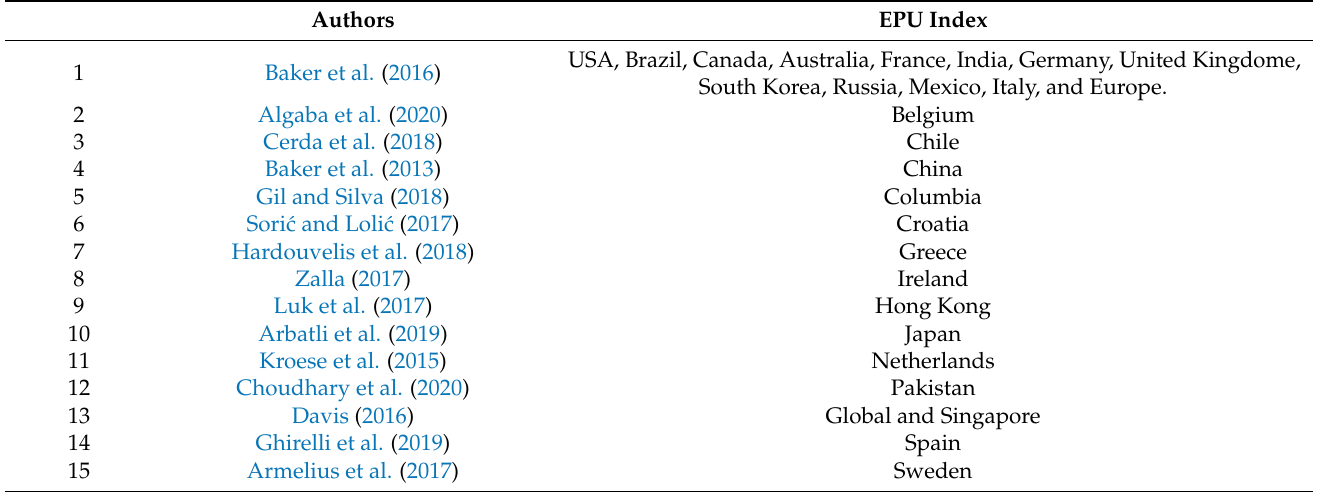
Table 1. Available EPU